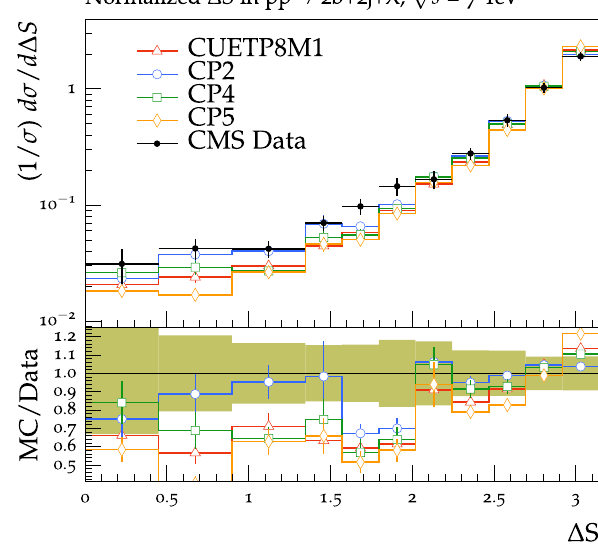
Fig. 18 The correlation observable Δ S measured in 4j (left) and simulations to the data (MC/Data) are also shown, where the shaded band indicates the total experimental uncertainty in the data. Vertical 2b2j (right) production, compared to predictions of pythia 8 tunes √ s = 7TeV anal- lines drawn on the data points refer to the total uncertainty in the data. CUETP8M1, CP2, CP4, and CP5, from the CMS Vertical lines drawn on the MC points refer to the statistical uncertainty yses [61,63]. Tunes CP1 and CP3 are not shown in the plot but show in the predictions. Horizontal bars indicate the associated bin a similar behaviour as, respectively, tunes CP2 and CP4. The ratios of